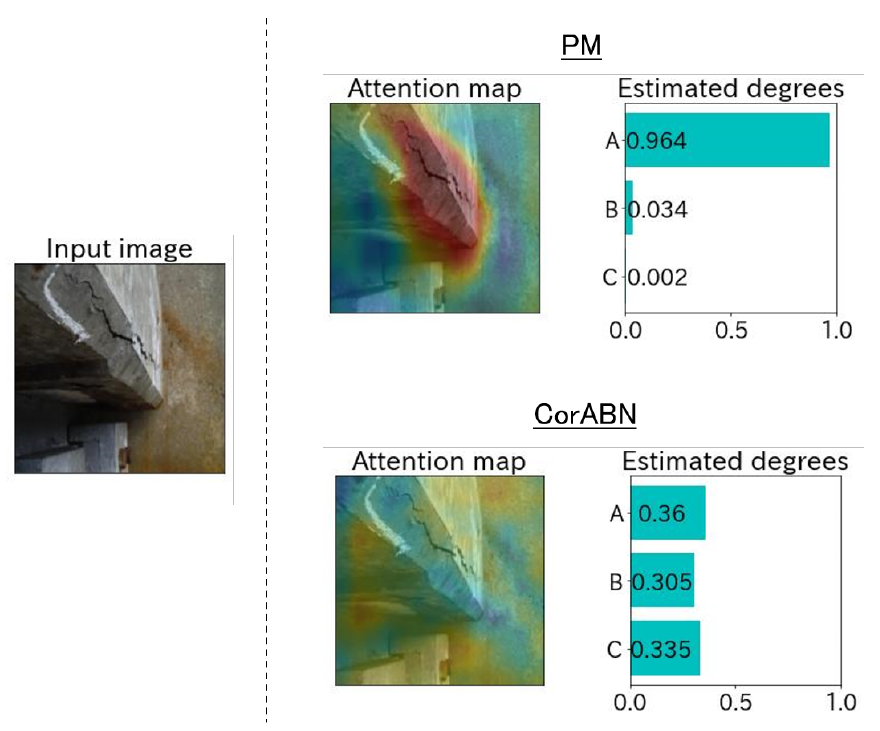
Figure 5. Estimated example at the degradation degree A for the distress type of rebar corrosion.